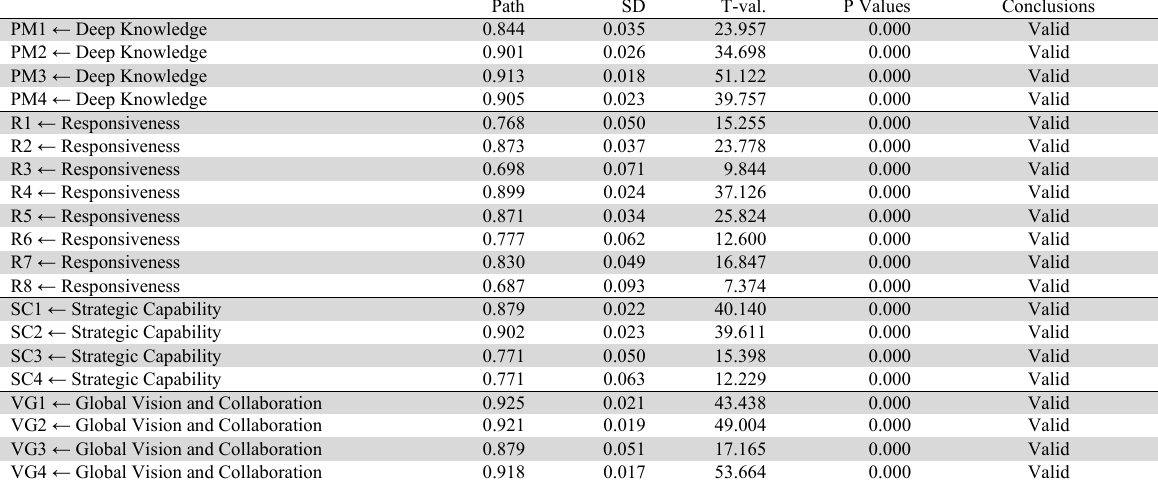
The results of outer loading (Continued)